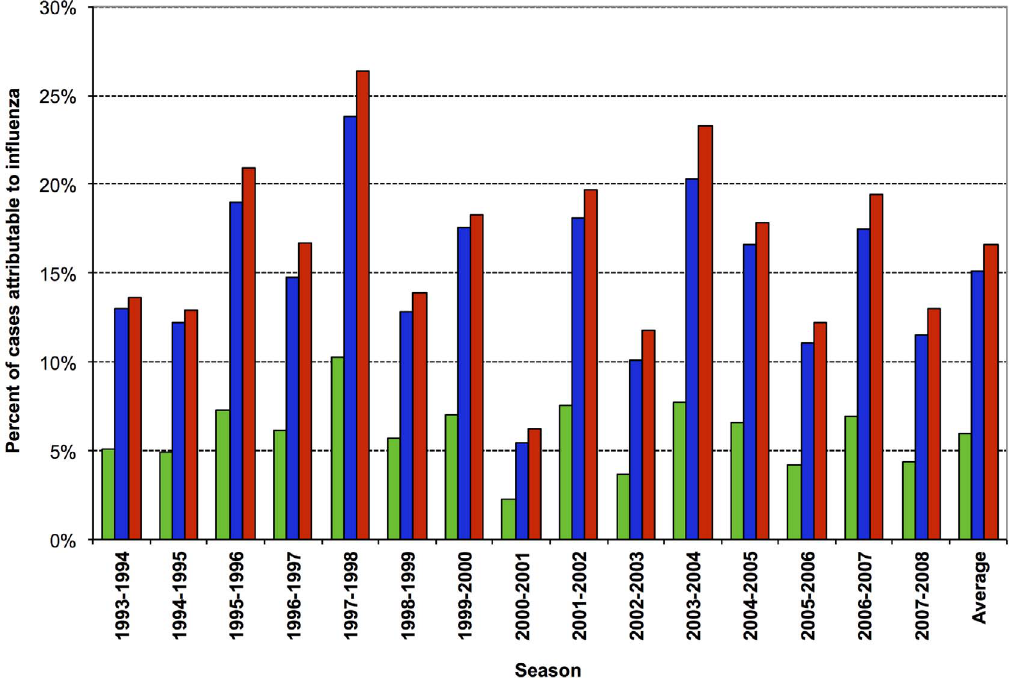
Figure 2. Proportion of outcomes that were influenza A-associated per season and overall. Percentage of all-cause mortality, 30-day pneumonia/influenza mortality, and pneumonia/influenza hospitalizations that were estimated to be influenza-associated during periods of influenza A circulation are indicated in the green, blue, and red columns, respectively.